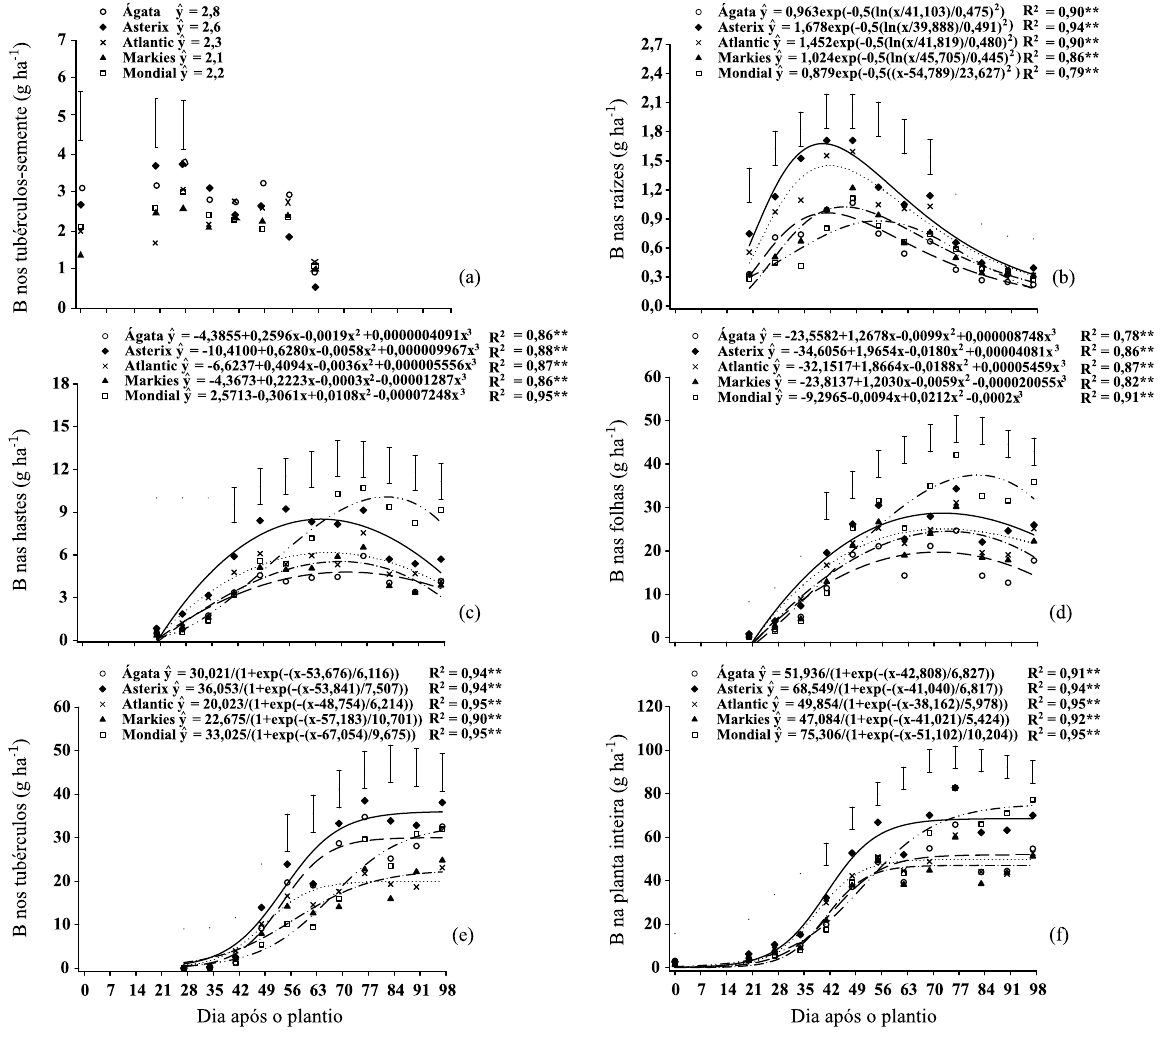
Figura 2. Quantidade de B nos tubérculos-semente (a), raízes (b), hastes (c), folhas (d), tubérculos (e) e na planta inteira (f) de cultivares de batata ao longo do ciclo. ** significativo a 1 % pelo teste F. Barras verticais indicam o valor de DMS pelo teste de Tukey a 5